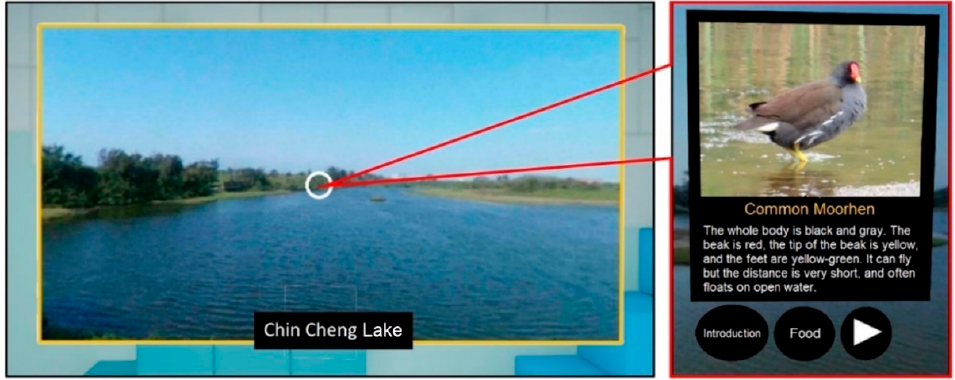
Figure 9. Searching for hidden icons to obtain the information about a creature.